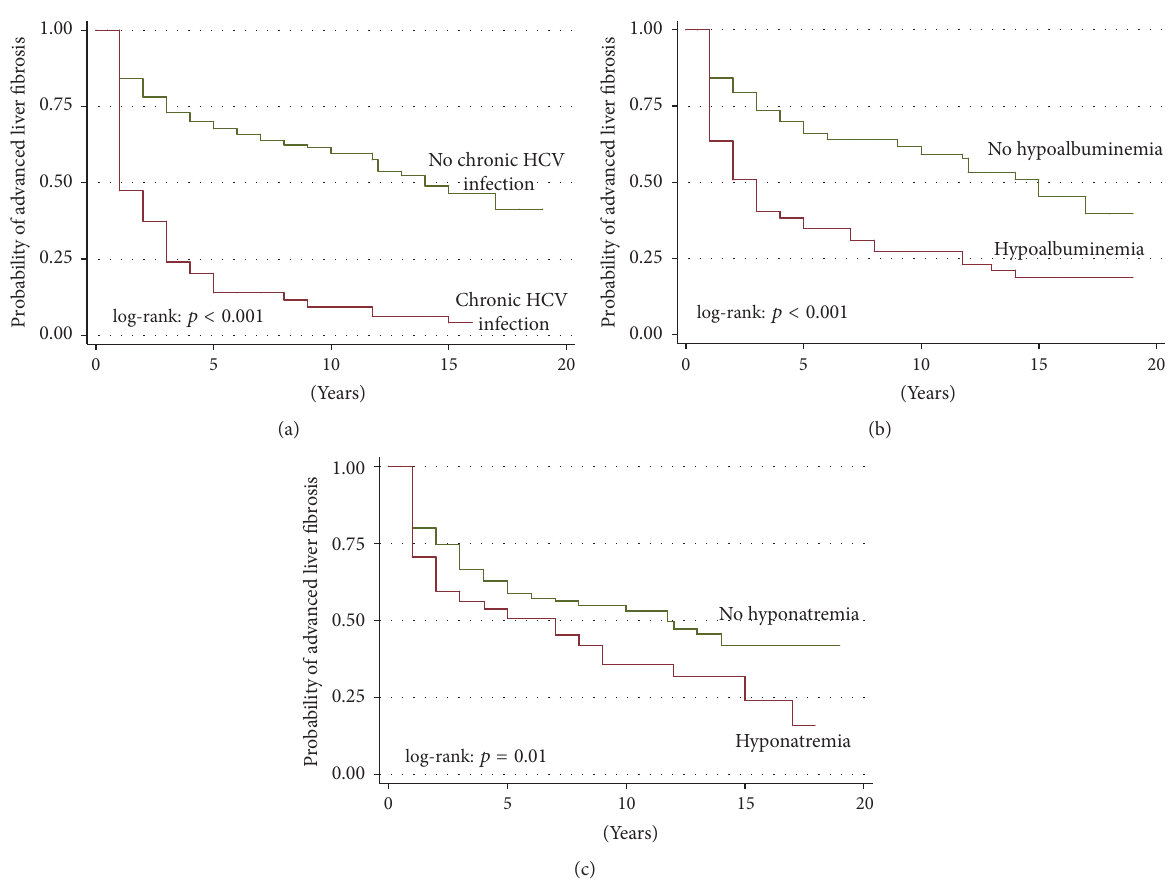
Figure 2: Survival curves of probability of advanced liver fibrosis development by: (a) chronic HCV category; (b) hypoalbuminemia category; (c) hyponatremia category. Table 2: Multivariate Cox regressions analysis of predictors of development of advanced liver fibrosis (FIB-4 > 3.25). Unadjusted HR 𝑝 Adjusted HR (95% (95% CI)